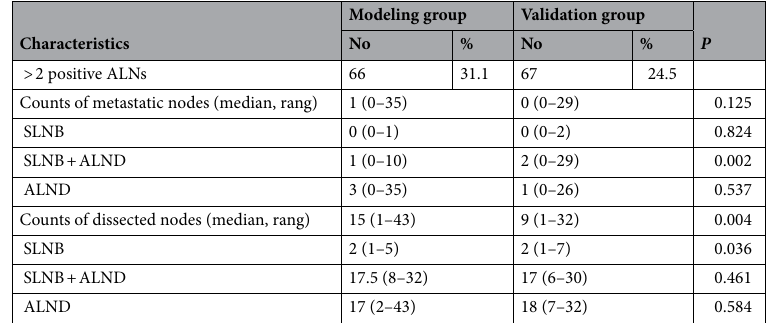
Table 1. Comparison of descriptive characteristics between the modeling group and the validation group. Abbreviation: ALN, Axillary lymph node; ALND, axillary lymph node dissection; CR, Central region; ER, estrogen receptor; HER2, human epidermal growth factor receptor 2; HR, hormone receptor; LIQ, Lower inner quadrant; LOQ, Lower outer quadrant; PR, progesterone receptor; SLN, sentinel lymph node; SLNB, sentinel lymph node biopsy; TN, triple negative; UIQ, Upper inner quadrant; UOQ, Upper outer quadrant.